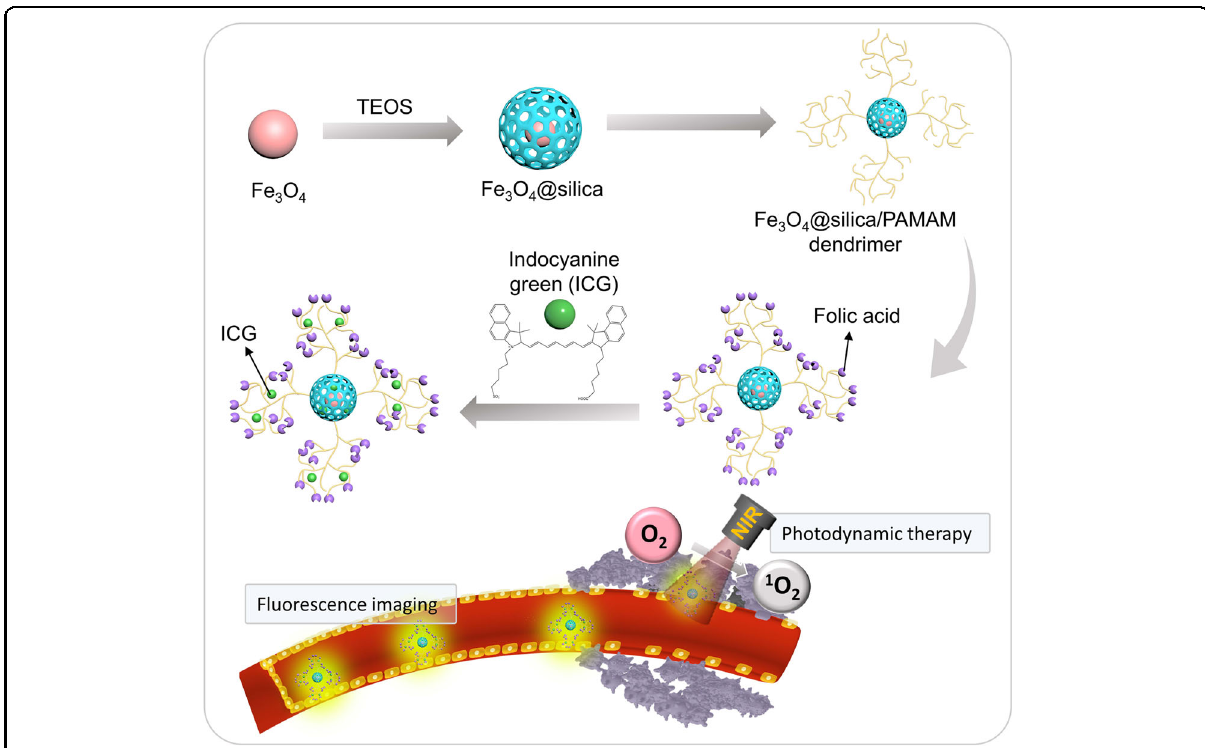
Fig. 16 Modi fi cation of dendrimer-functionalized mesoporous nanoparticles based on an active targeting strategy. Addition of targeting moieties such as folic acid to the mesoporous nanoparticle improves the speci fi city to tumor site, leading to the high antitumor ef fi